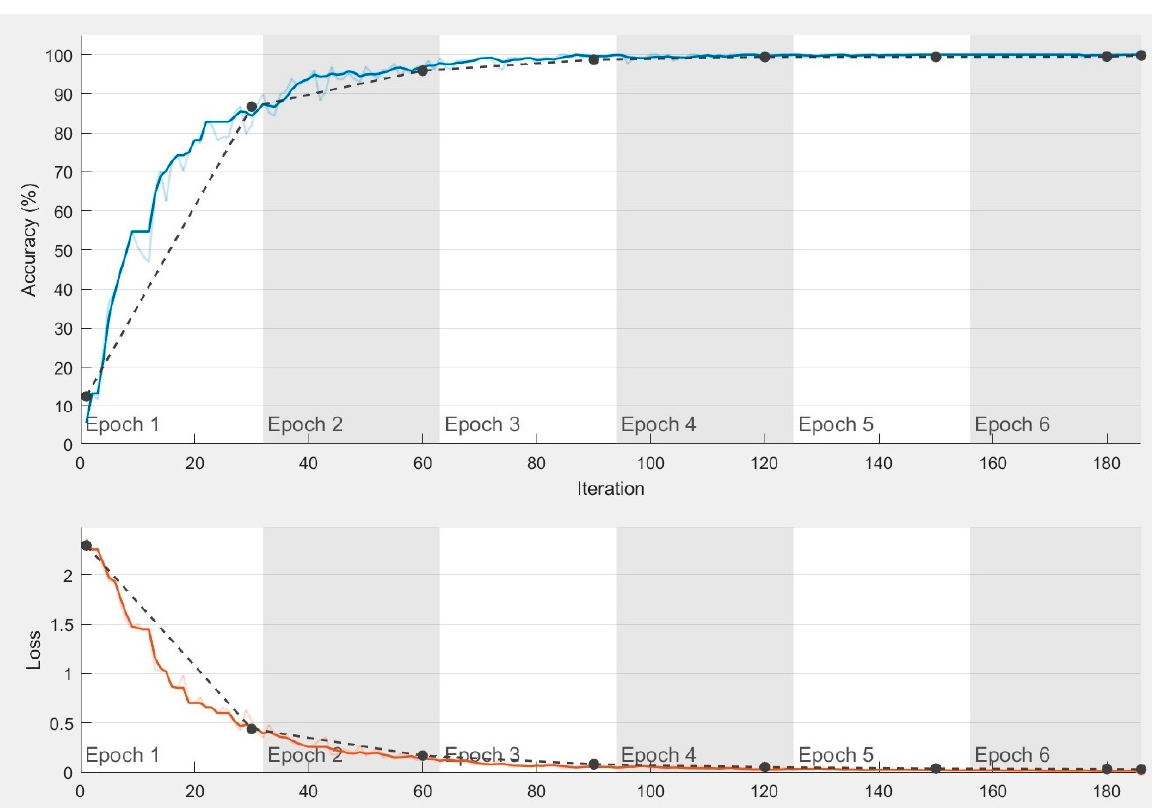
Figure 7. ( a ) Receiver operator characteristics (ROC) curve ( b ) Precision-recall (PR) curve of the proposed approach.